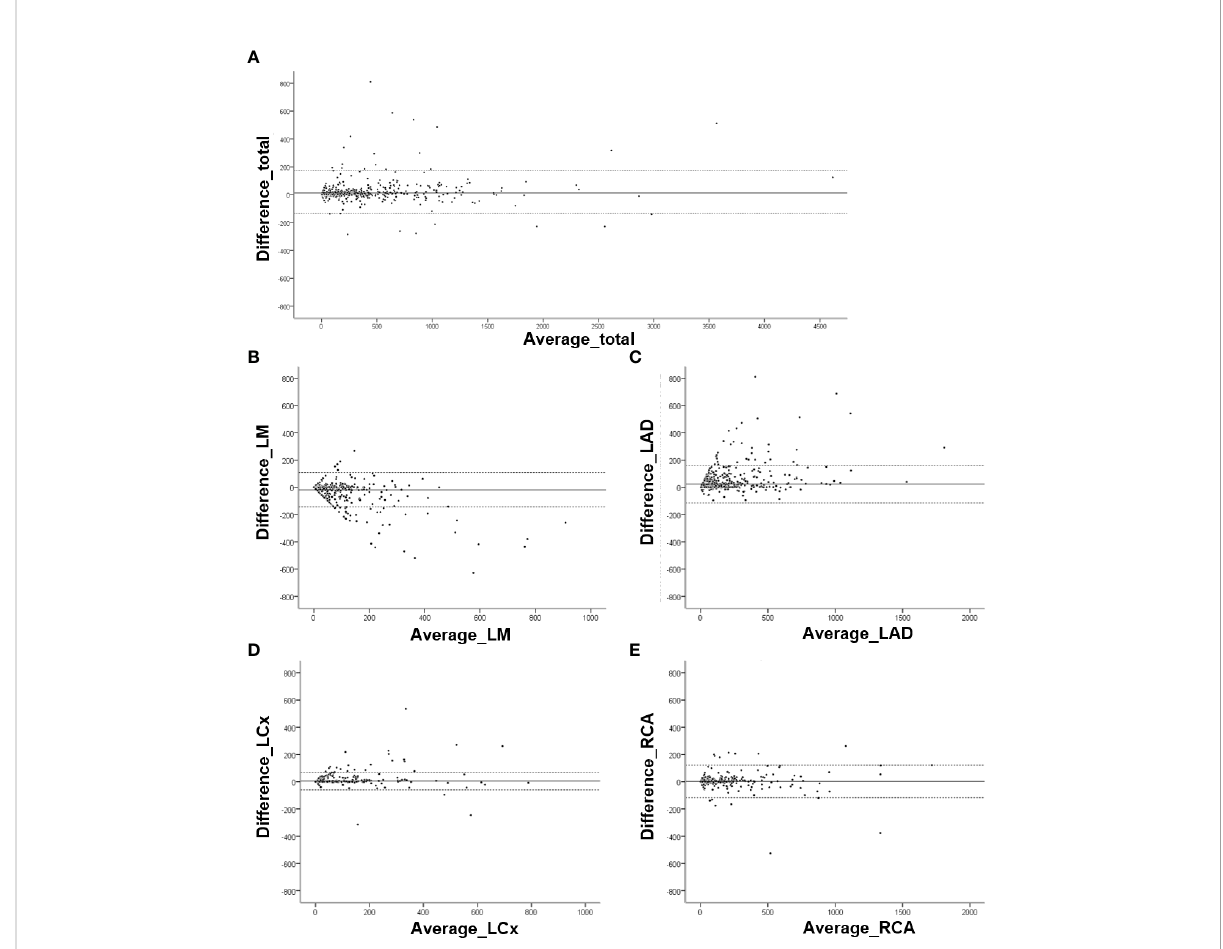
FIGURE 2 Bland – Altman analysis for Agatston scores obtained by manual and fully automated methods. Graphs for (A) Total Agatston score (mean difference, 12.08; 95% limits of agreement [LOA], -133.59 and 157.74), (B) left main (mean difference, -18.70; 95% LOA, -145.23 and 107.83), (C) left anterior descending (mean difference, 23.56; 95% LOA, -115.14 and 162.27), (D) left circum fl ex (mean difference, 4.55; 95% LOA, -59.88 and 68.97), and (E) right coronary (mean difference, 2.09; 95% LOA, 87.73 and 91.91) arteries.